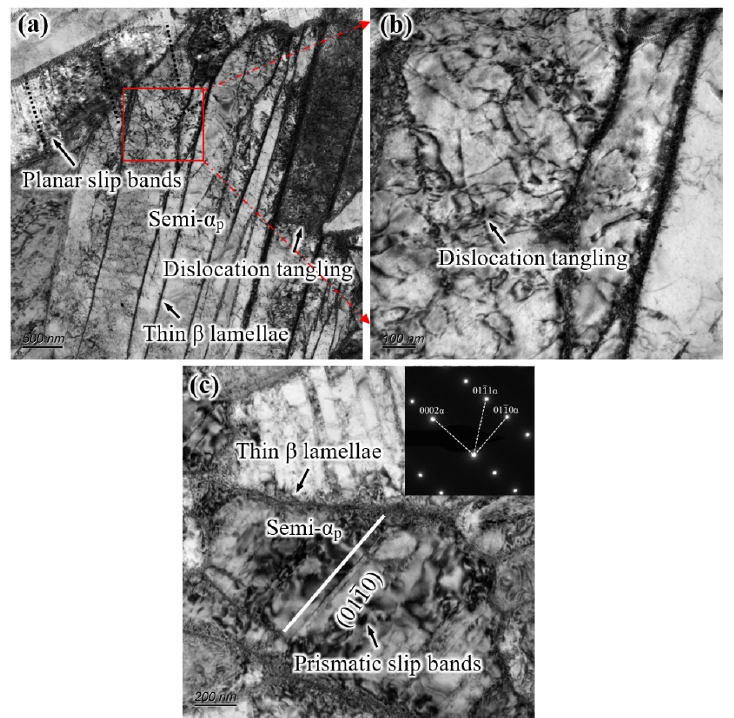
Figure 11. Deformation behavior of the tensile specimen with the S-EM: ( a , b ) dislocation tangling and planar slip bands between the thin β lamellae of the semi-equiaxed α p phase and ( c ) prismatic slip bands between the thin β lamellae of the semi-equiaxed α p phase.